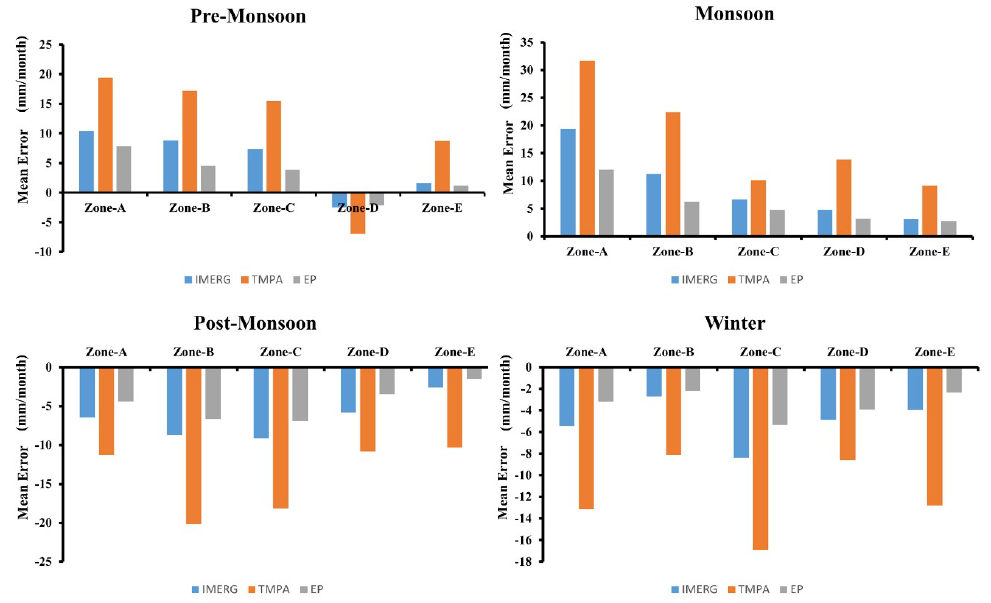
Figure 5. Mean error (ME) of satellite products and EP algorithm during the pre‐monsoon, monsoon, post‐monsoon and winter seasons.